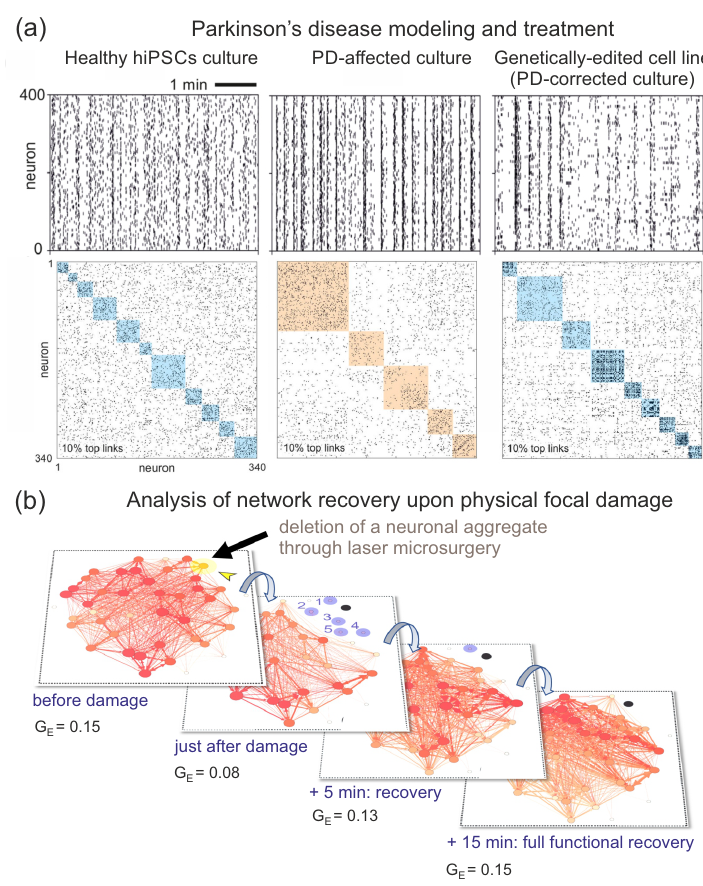
Figure 7. Neurological disorders and damage in vitro. ( a ) comparison of hiPSC-derived cultures in a model for Parkinson’s disease (PD), showing raster plots of spontaneous activity on top and effective connectivity matrices at the bottom. Color boxes in the matrices highlight communities. From left to right, data correspond to a healthy culture, a culture derived from cells affected by a genetic form of PD, and a culture whose cells were genetically-edited to correct for the disease.The PD culture exhibits an excessive integration, with stronger synchronization in the raster plots and bigger communities; ( b ) recovery of an aggregated culture after laser microsurgery (yellow spot before damage, black spots after it). Colored discs and lines represent aggregates and effective connections, respectively, with their color intensity proportional to their connectivity or strength. The discs in blue mark those aggregates that became silent just after damage but that gradually recovered activity and effective connections along recovery. In both panels ( a ) and ( b ), data were obtained using Fluo-4 as a calcium